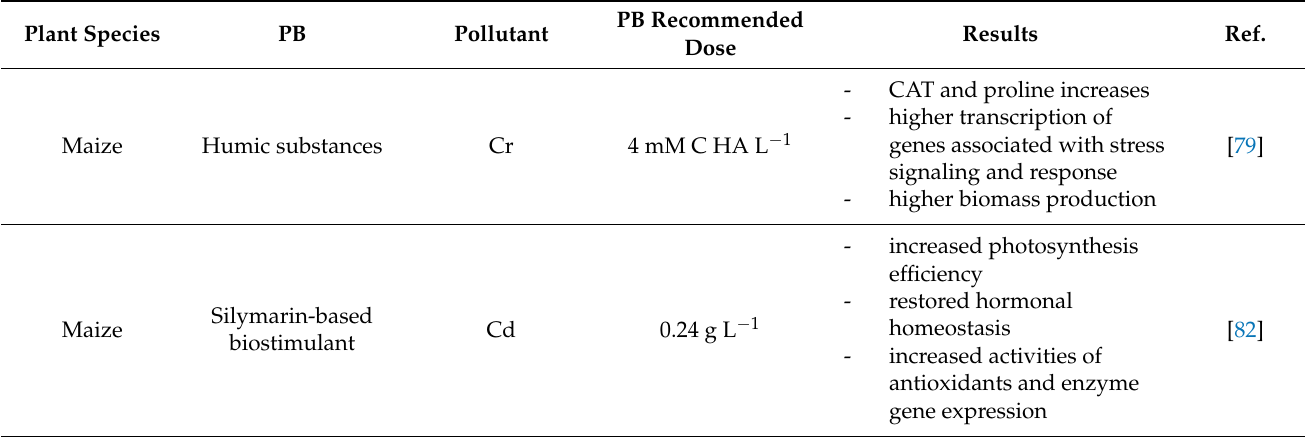
Table 2. Effects of PBs in ameliorating the stress response generated by pollutants in plants. Plant Species Results